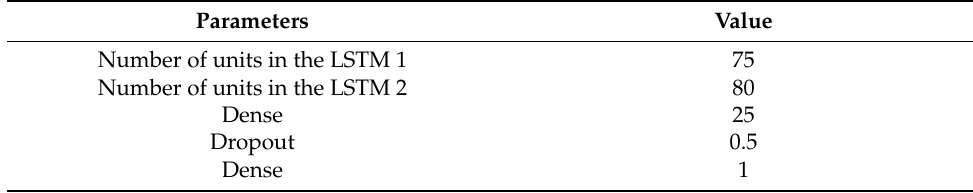
Table 3. Hyperparameters setting of LSTM model.